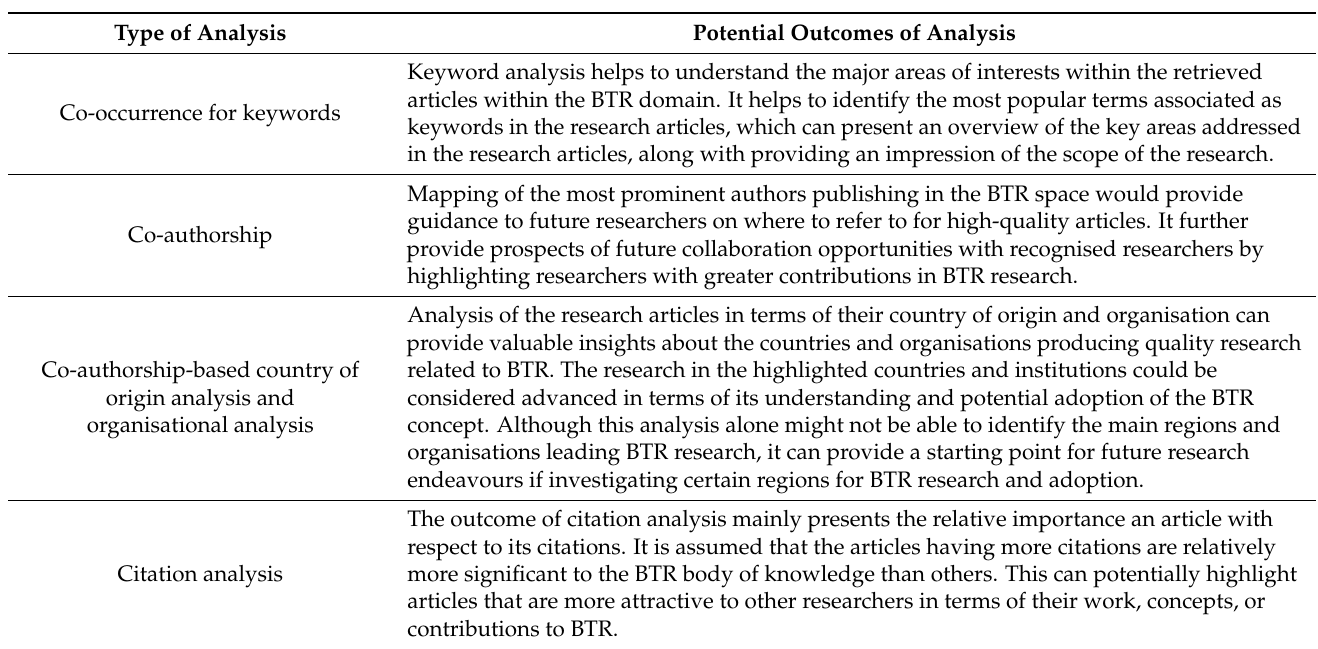
Table 4. Importance of various types of analysis carried out on the retrieved